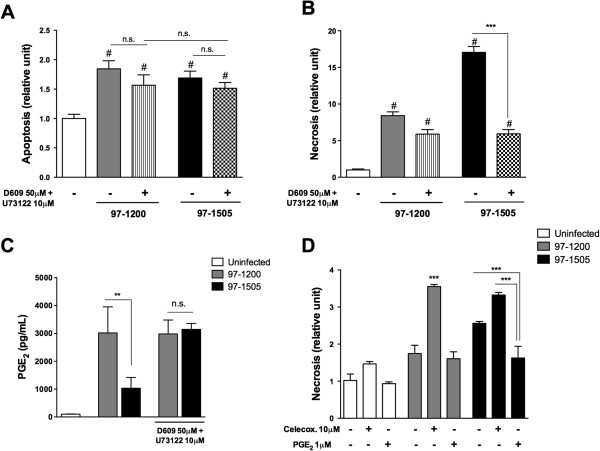
PLC-expressing Mycobacterium tuberculosis induces alveolar macrophage necrosis through the regulation of PGE2 synthesis. Alveolar macrophages were infected in vitro for 24 h with Mtb isolates 97-1200 or 97-1505 treated or not with the PLC inhibitors D609 (50 μM) and U73122 (10 μM). (A, B) ELISA assay of apoptosis and necrosis. (C) PGE2 production was assessed in supernatants by ELISA. (D) Celecoxib or PGE2 were added to the culture of alveolar macrophages infected or not with 97-1200 or 97-1505 and necrosis was assessed by ELISA. #P < 0.0001 for uninfected cells vs. infected cells (97-1505 or 97-1200); ***P < 0.0001; **P < 0.001 (one-way ANOVA). Data are representative of three (A, B) and two (C, D) independent experiments (error bars, s.e.m.).